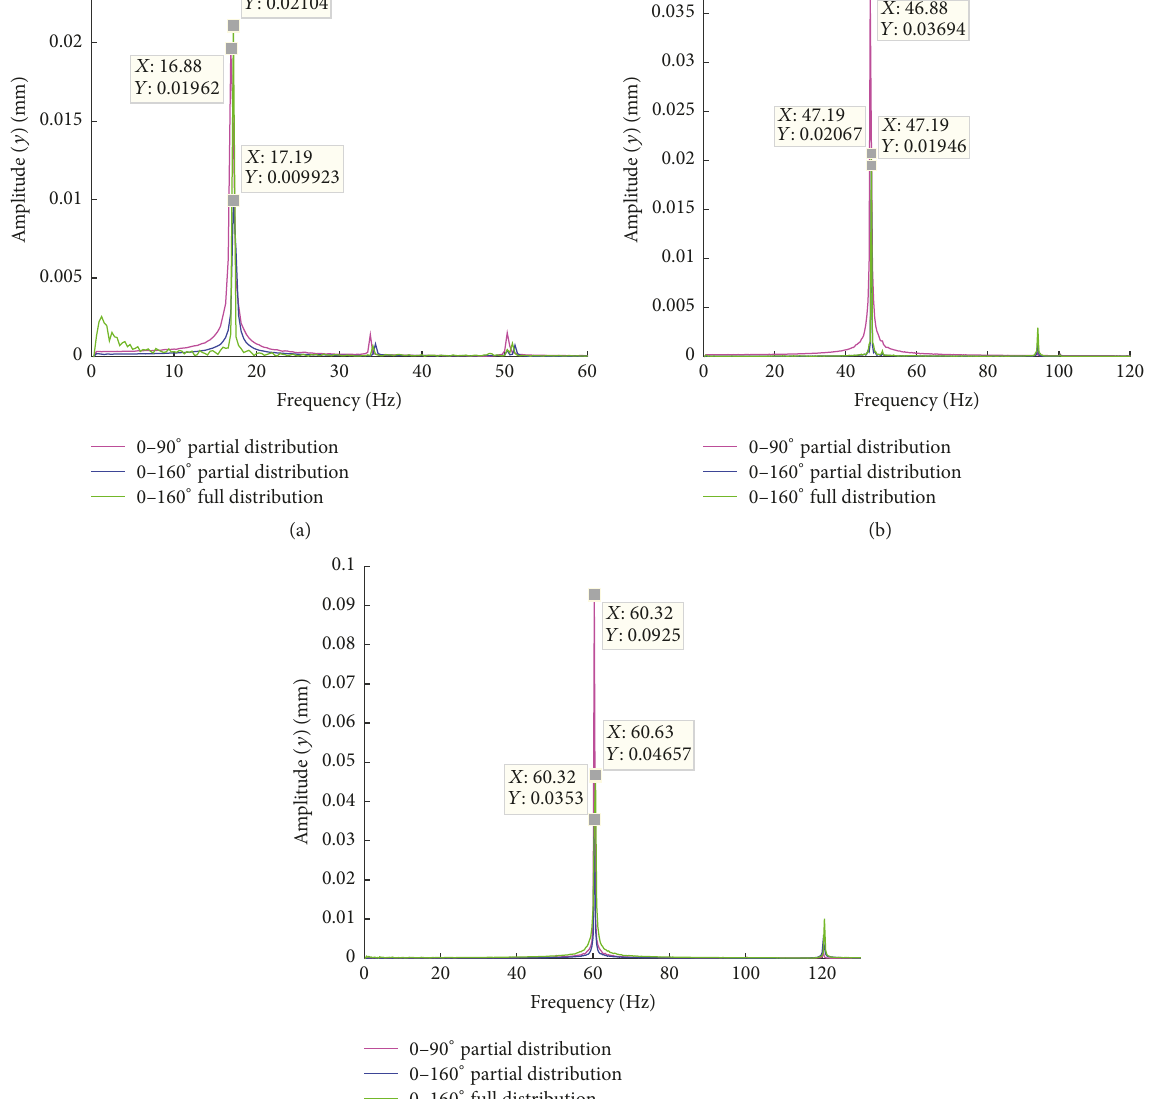
shaft center orbit of the bearings with 0–160 ∘ par- tially distributed textures tends to be more flat and smaller than the others, which indicates that it is less likely to produce destabilizing effect. Besides, fre- quency spectrum analysis is added to demonstrate the